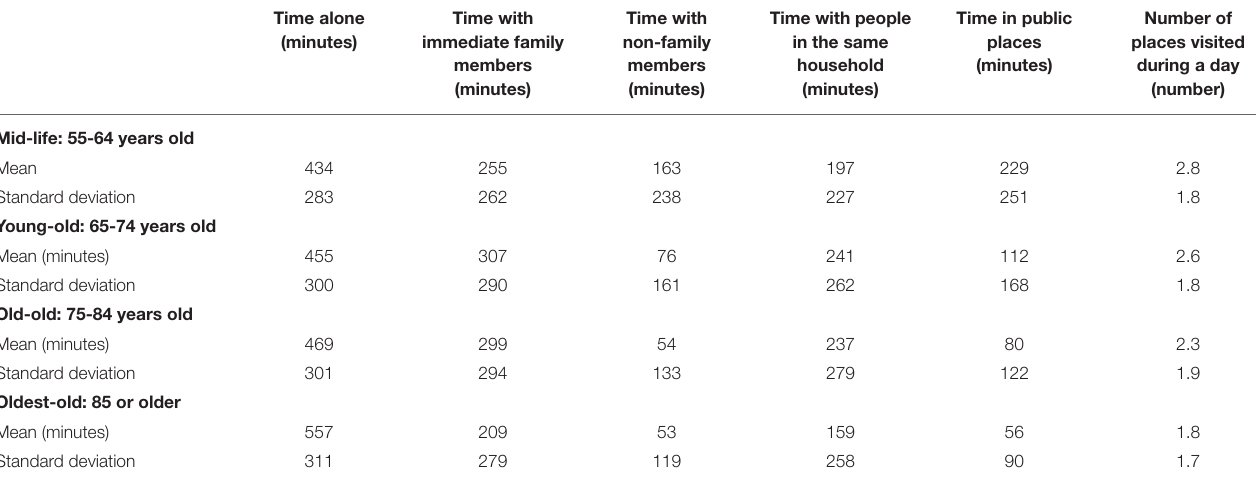
TABLE 2 | Summary statistics of measures of extent and degree of social contact by age group (weighted, N =